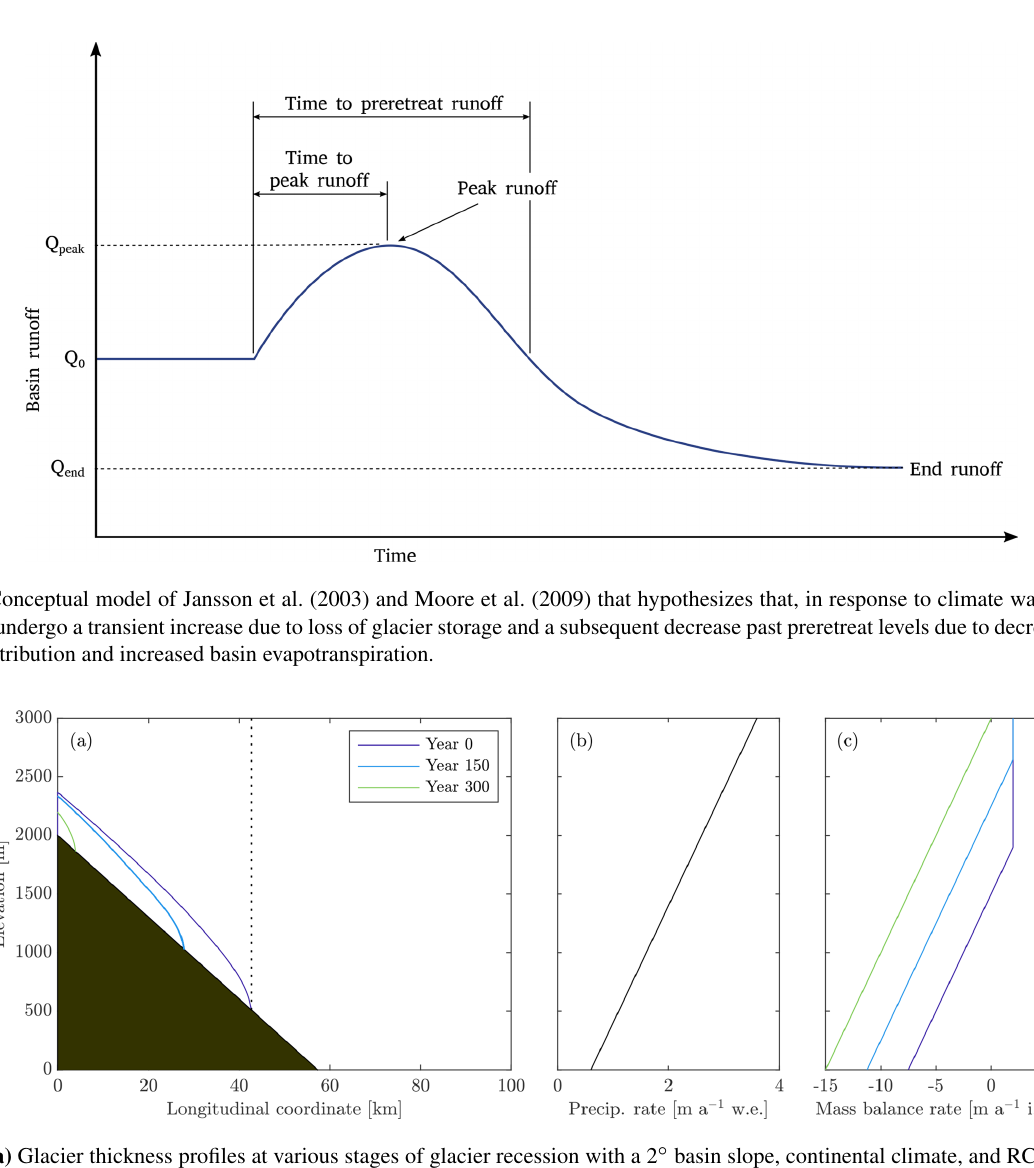
Figure 2. (a) Glacier thickness profiles at various stages of glacier recession with a 2 ◦ basin slope, continental climate, and RCP8.5 climate change scenario. The dotted vertical line demarcates the basin extent. (b) Precipitation rate with altitude, which is held constant throughout glacier retreat. (c) Specific mass balance rate with altitude at various times during glacier recession. The ELA occurs where the mass balance rate equals